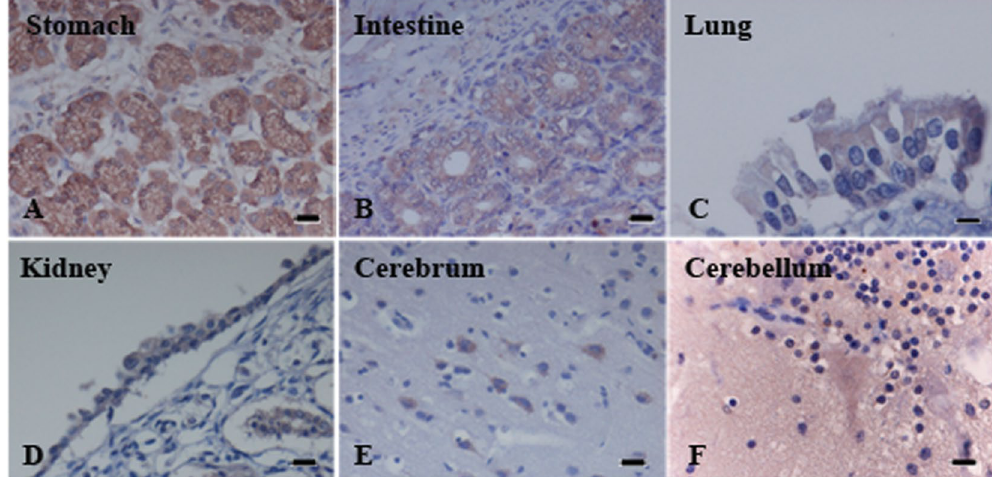
Figure 1. Immunohistochemistry of nectin-4 expression in normal canine tissues. Glandular epithelial cells of stomach ( A ) and intestine ( B ) showed strong immunoreactivity. Bronchial epithelial cells of lung ( C ) and pelvis epithelial cells of kidney ( D ) revealed moderate immunopositive. Neurons at cerebrum ( E ) displayed moderate to weak intensity. Purkinje’s cells at cerebellum ( F ) were positive weakly. (Bar = 20 μ